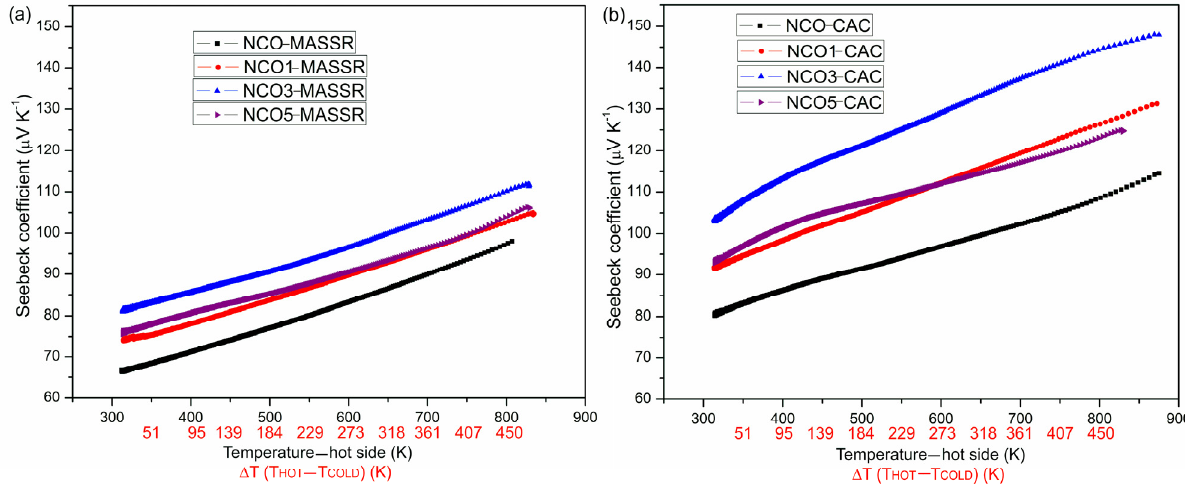
Figure 6. Temperature dependence of the Seebeck coefficient of the ( a ) MASSR and ( b ) CAC samples for the temperature gradients ∆ T at the temperatures of the hot side of the